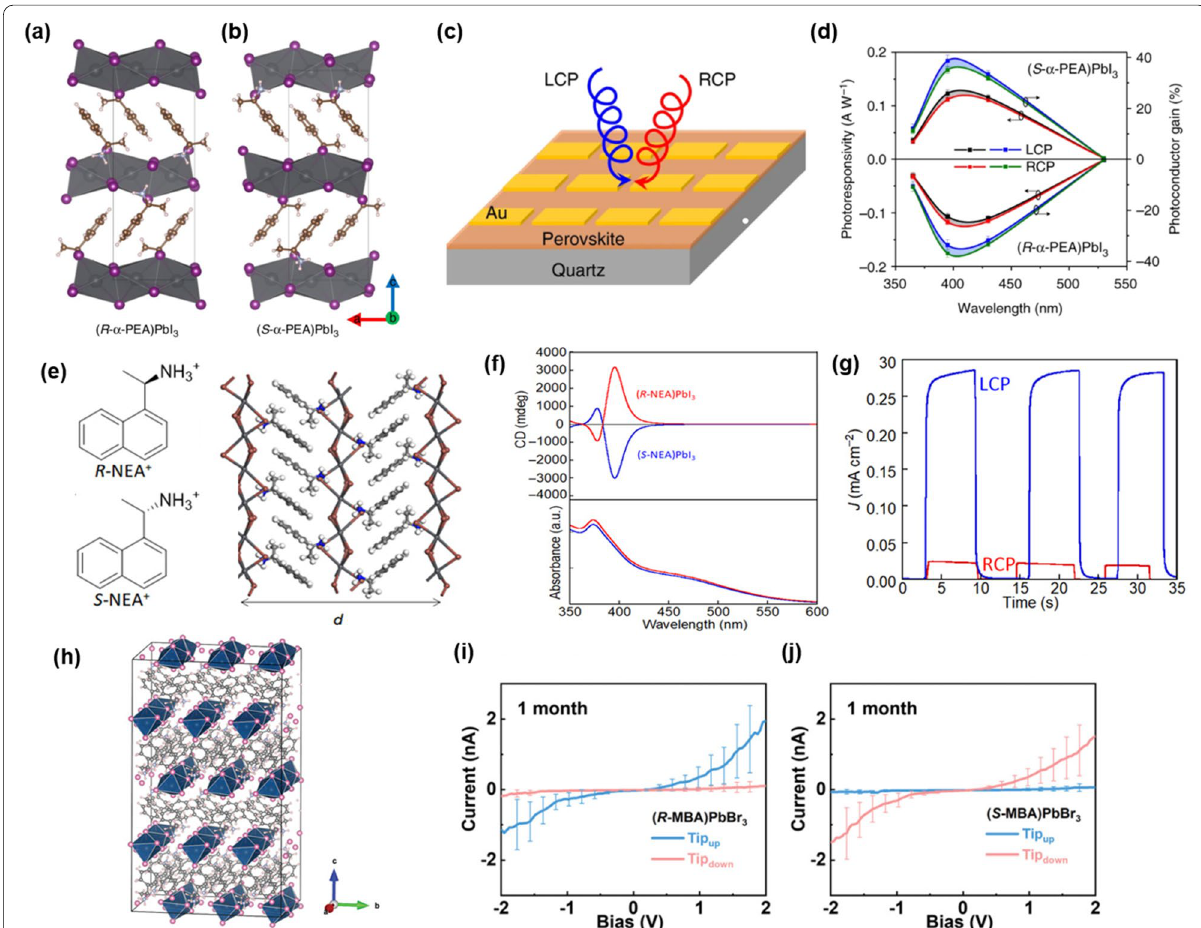
Fig. 5 The crystal structure of a ( R -MBA)PbI 3 and b ( S -MBA)PbI 3 . c Schematic diagram of 1D chiral (MBA)PbI 3 based CPL detector. d The responsivity and photoconductor gain of 1D chiral HOIPs with opposite handedness under LCP and RCP. Reproduced with permission from [38]. Copyright 2019 Nature Publishing Group. e The molecular structure of R -NEA and S -NEA. f CD and absorption spectra of 1D chiral (NEA)PbI 3 . g Time course of photoresponse of ( R